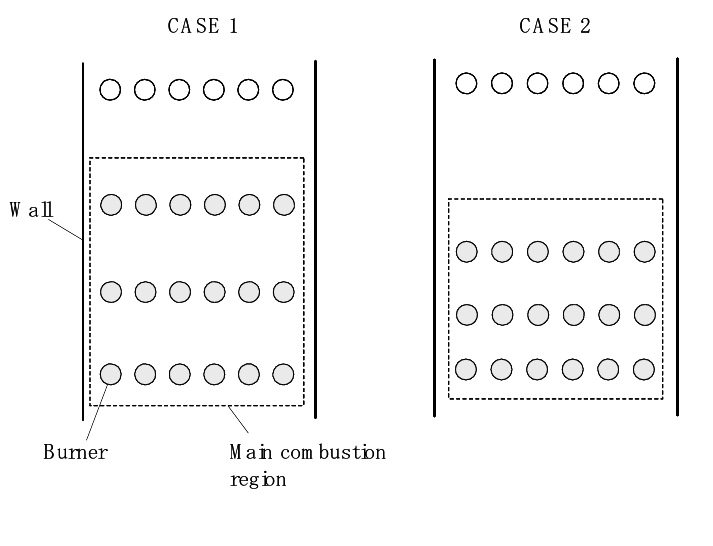
Figure 15. Arrangement of Burners for CASE 1 and CASE